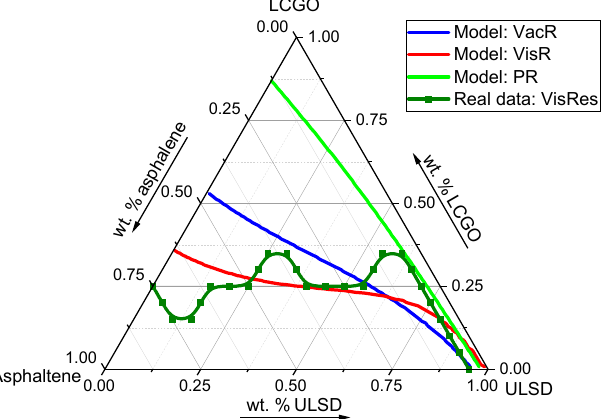
Figure 4. Simulation results of the asphaltene–ULSD–LCGO system in comparison with the data obtained experimentally (the composition is indicated in mass fractions). For samples with a molecular weight of 1518 g/mol the average deviation is also not so large, but due to the absence of an inflection on the theoretical isotherm, the solubility change trend is poorly conveyed. The situation is even worse with the mass of 450 g/mol sample isotherm. In fact, in general, it incorrectly shows the solubility process in the rich in aromatic hydrocarbons area. This result should be considered in conjunction with the results of the previous sec- tion. Two of the four most important characteristics of asphaltenes (heat of fusion, melt- ing point, molecular weight and group composition) viz. the heat of fusion and molecular weight have the greatest influence on solubility. By decreasing the heat of fusion and in- creasing the molecular weight, a sufficiently large solubility value can be obtained. However, the heat of fusion was taken as an average value for polyaromatic hydrocar- bons and was not measured experimentally. On the contrary, the average molecular weight and elemental composition were determined experimentally. The proposed model is supported by the fact that the best agreement between the theoretical isotherm and the experimental data was obtained for the experimental parameters. The proposed model has similar trends, but differs significantly from the data ob- tained experimentally, since the experimental curve in the diagram is built using the marine fuel component, visbreaking residue, which contains 26.6% wt. asphaltenes, not pure asphaltenes. Undoubtedly, the hydrocarbon composition of the fuel (namely, the content of resins and arenes) influences the stability of the fuel system the most. When considering a system consisting of VisR, and not VisR asphaltenes in pure form, and two solvents (ULSD and LCGO) in the same ratios, the dispersed medium will have a dif- ferent hydrocarbon composition, so when comparing the data obtained, only the trends in the solubility of asphaltenes can be discussed. To summarize the results obtained, Figure 5 shows the calculation of the solubility of asphaltenes in a hypothetical solution of two groups of the UNIFAC model: AC and CH 2 . In this case, they represent a generalization of the aromatic and aliphatic compo- nents of petroleum products. In these coordinates, the solubility isotherms are practically straight lines. The solubility of asphaltenes in both groups is less than 10 mass percent. The non-linear course of the solubility isotherm in the case of using ULSD and LCGO as a solvent is explained by the fact that they both contain both aromatic and aliphatic groups. Due to the simultaneous presence of these groups at once in ULSD and LCGO, the iso-